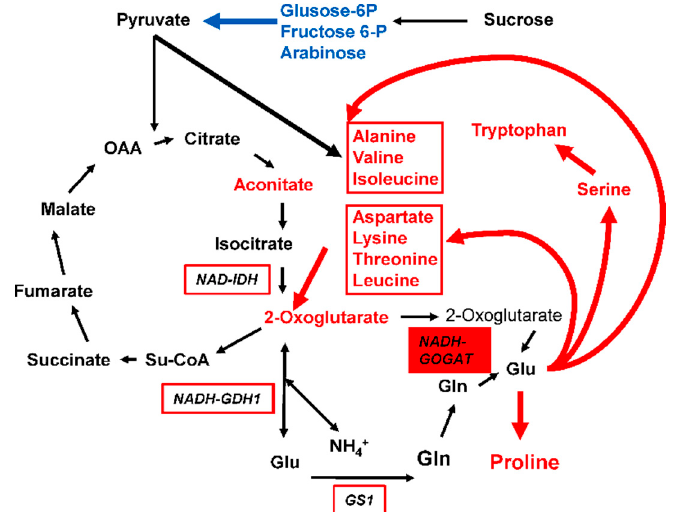
Figure 5. Scheme of amino acid biosynthesis derived from glutamate. Metabolites in red font are present in higher amounts in the leaves of maize plants overexpressing NADH-GOGAT (red box). Those in blue font are present in lower amounts. Red arrows indicate the putative metabolic pathways involved in the synthesis of amino acids and the release of 2-Oxoglutarate. The blue arrow corresponds to the use of carbohydrates to produce Pyruvate. The other enzymes used for gene pyramiding are boxed with a red line.